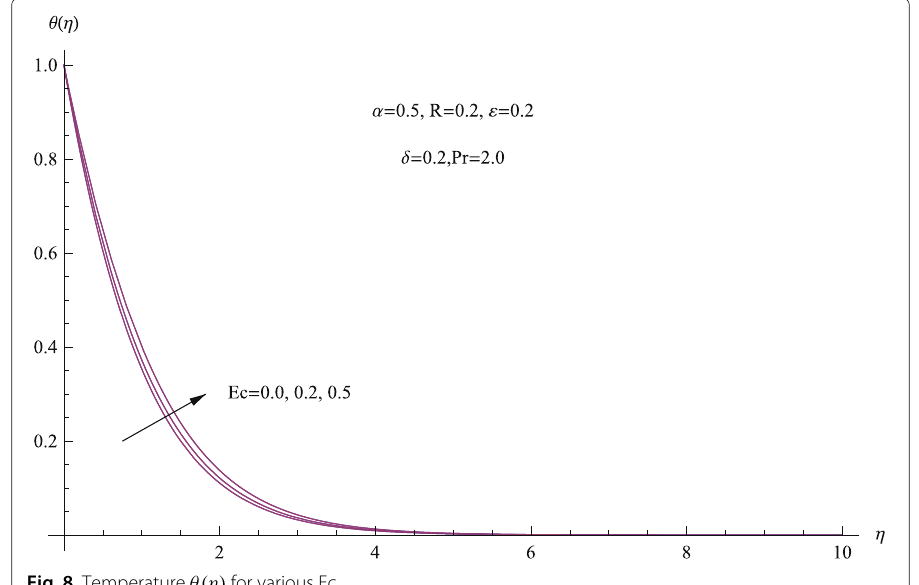
Fig. 8 Temperature θ(η) for various